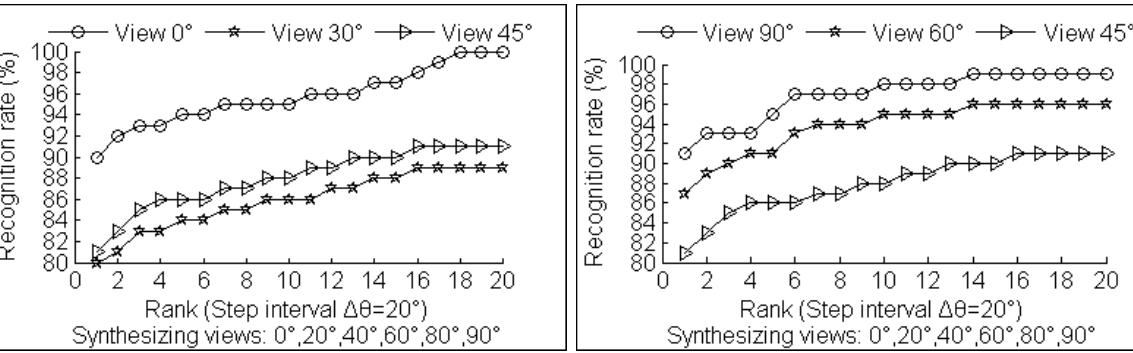
Figure 18. Recognition results with step interval ∆θ =